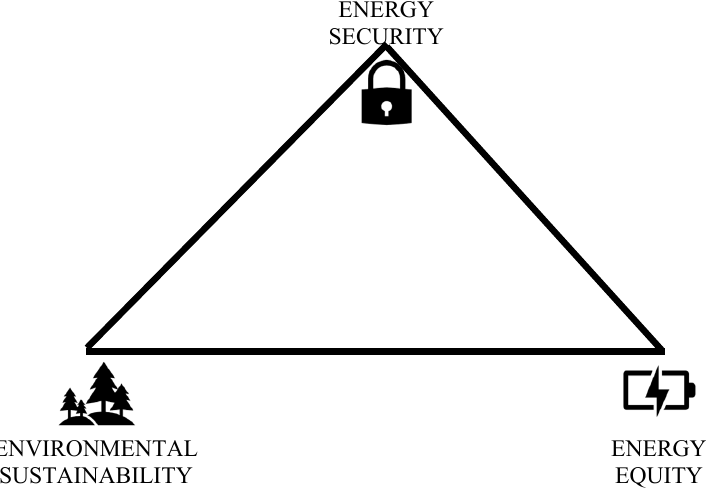
Fig. 3. Trilemma Energy (Gunningham,